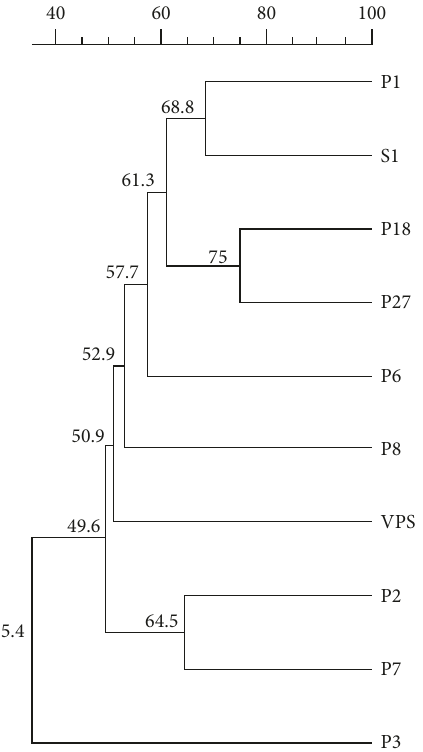
Figure 7: Cluster analysis of 16S rDNA PCR-DGGE profiles from the groundwater samples collected at the wells P1, P2, P3, P6, P7, P8, P18, P27, and VPS, and at the spring S1 (dice coefficient with the UPGMA clustering algorithm). Similarity values are